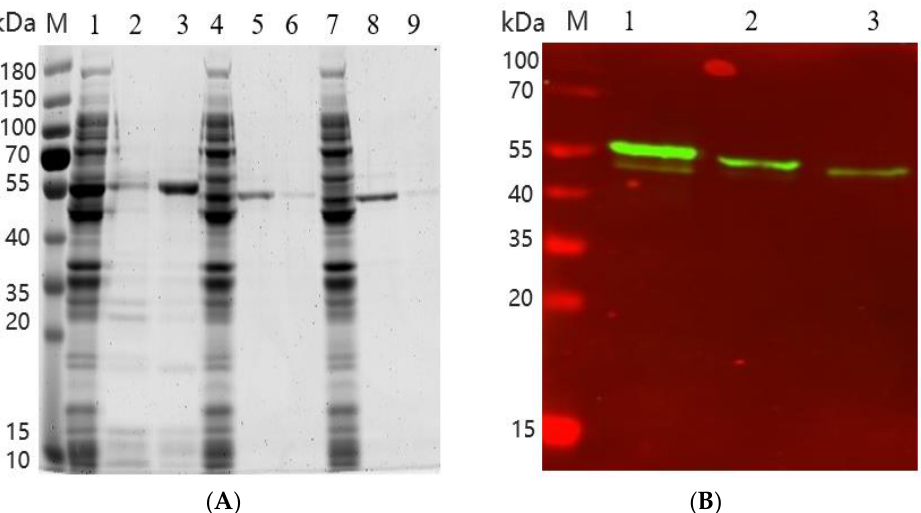
Figure 5. ( A ) SDS-PAGE of the recombinant protein. Lane M, molecular weight marker. Lane 1, crude enzyme solution of FumTSTA. Lane 2, purified recombinant FumTSTA (200 mM Imidazole elution). Lane 3, purified recombinant FumTSTA (300 mM Imidazole elution). Lane 4, crude enzyme solution of FumPHTA. Lane 5, purified recombinant FumPHTA (200 mM imidazole elution).